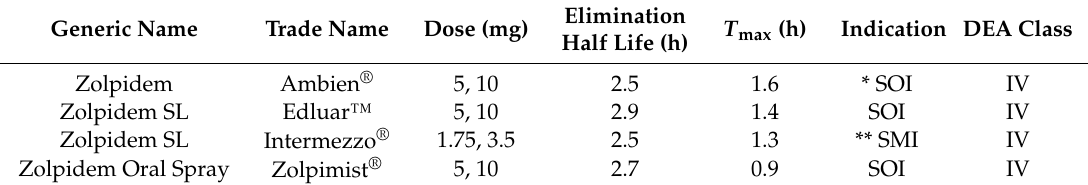
Table 2. Zolpidem and its